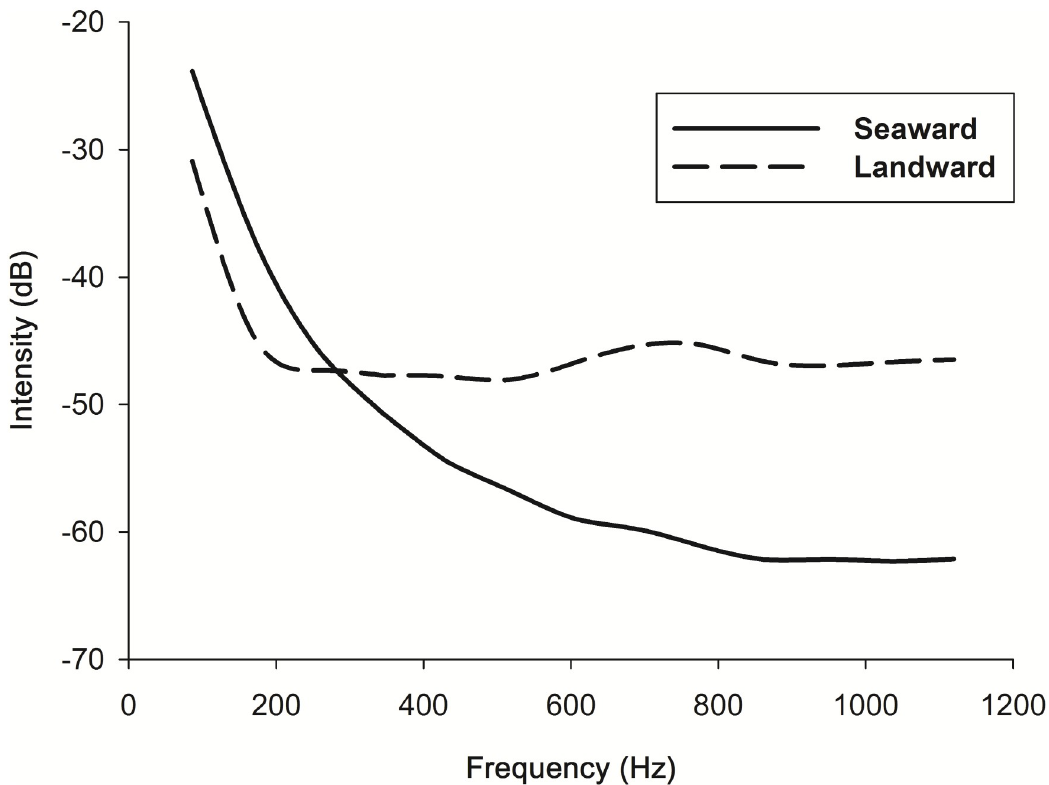
Fig 3. Sound intensity detected by receivers pointing seaward versus landward at the shore of Wanliton, south